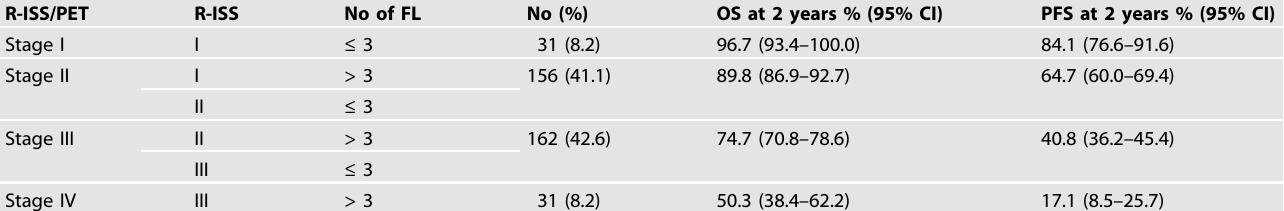
Table 2. New risk strati fi cation system including the number of focal lesions on PET/CT with the